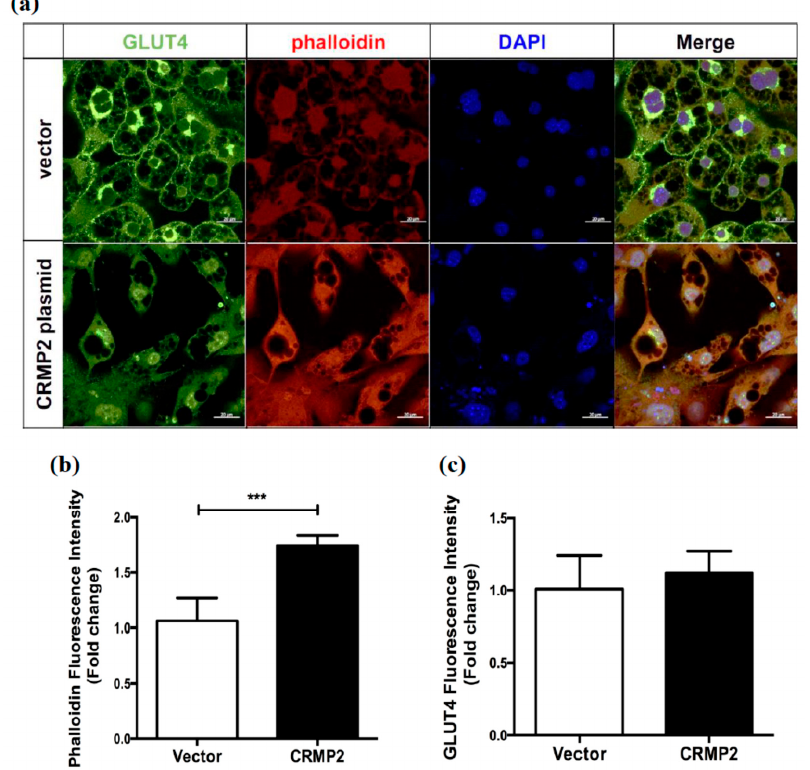
Figure 4. E ff ects of CRMP2 overexpression on cytoskeleton and GLUT4 expression. CRMP2-expressing or control vector were transfected into the cells on day 4 after entering di ff erentiation. ( a ) Expression patterns of GLUT4 and phalloidin-positive actin filaments were detected and quantified in mature transfects on day 8 by immunofluorescence. The images were captured using a Zeiss LSM 880 laser confocal microscope, scale bars = 20 µ m. The images RGB plots were measured and generated by ImageJ RGB profile plots. ( b , c ) Data were presented as means ± SEM of about 50 cells in each group, and analyzed by one-tailed unpaired Student t -test. *** p <